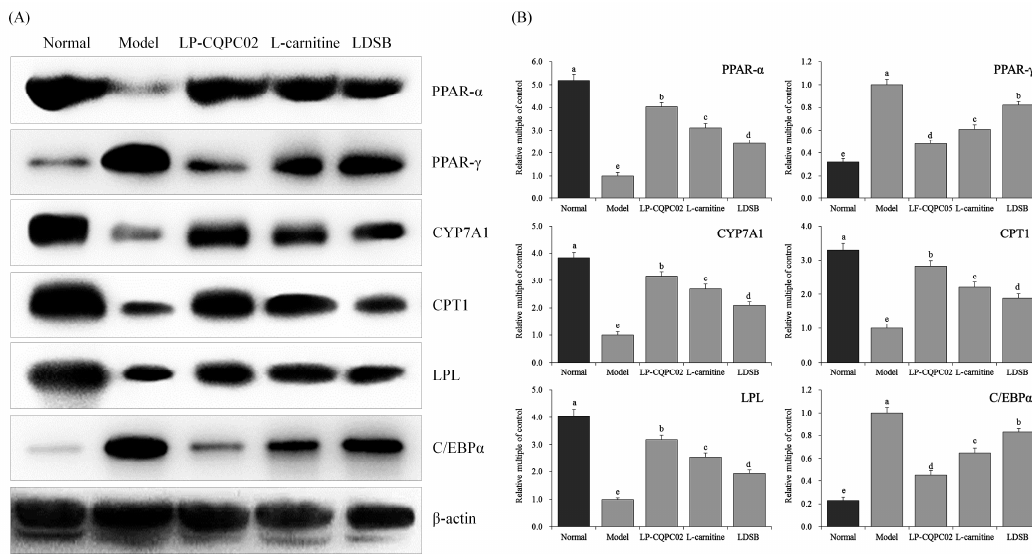
Figure 5. The PPAR- α , PPAR- γ , CYP7A1, CPT1, LPL and C/EBP α mRNA (A) and protein (B) expression in epididymis tissue of mice. a–e Mean values with different letters above the bar are significantly different ( p < 0.05) according to Duncan’s multiple-range test. LDSB: Mice treated with 1.0 × 10 9 CFU/kg of Lactobacillus delbruechii subsp. bulgaricus ; LP-CQPC02: Mice treated with 1.0 × 10 9 CFU/kg of Lactobacillus plantarum CQPC02; L -carnitine : Mice treated with 200 mg/kg of L -carnitine.